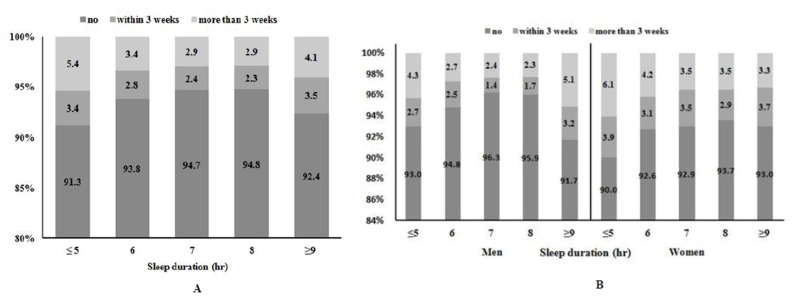
Distribution of dysphonia by sleep duration, stratified by duration of symptom.(A) Data for all participants and (B) data for men and women.